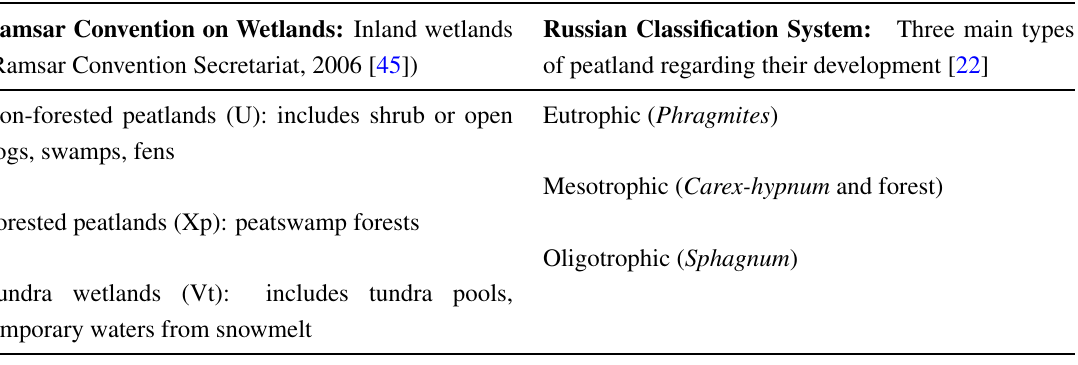
Table 2. Peatland classification systems.